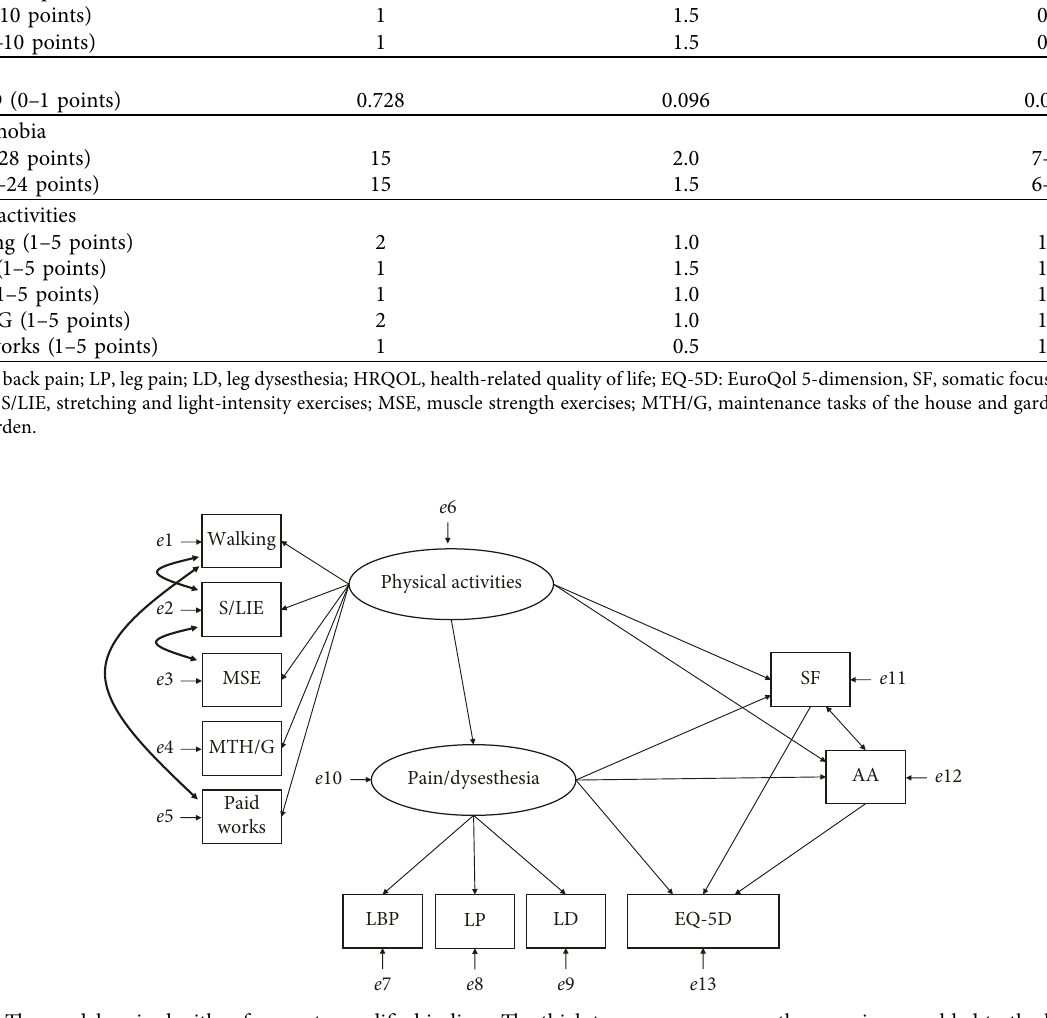
Figure 3: The model revised with reference to modified indices. The thick two-way arrows are the covariances added to the hypothetical model. S/LIE: stretching and light-intensity exercises; MSE: muscle strength exercises; MTH/G: maintenance tasks of the house and garden including kitchen garden; SF, somatic focus; AA, activity avoidance; EQ-5D, EuroQol